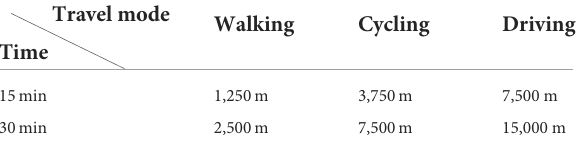
TABLE 5 Summary of accessibility search thresholds for